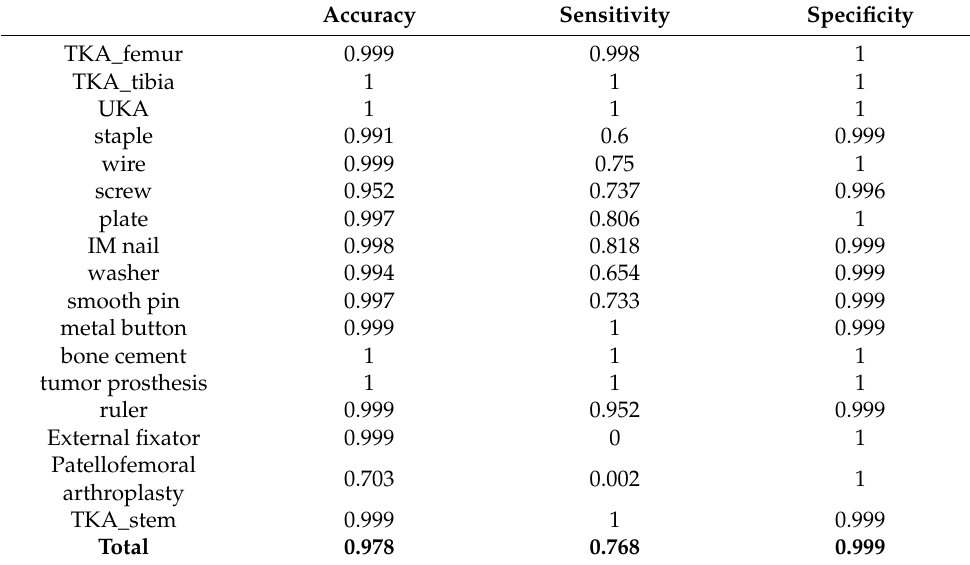
Table 2. Evaluation metrics on the validation set.